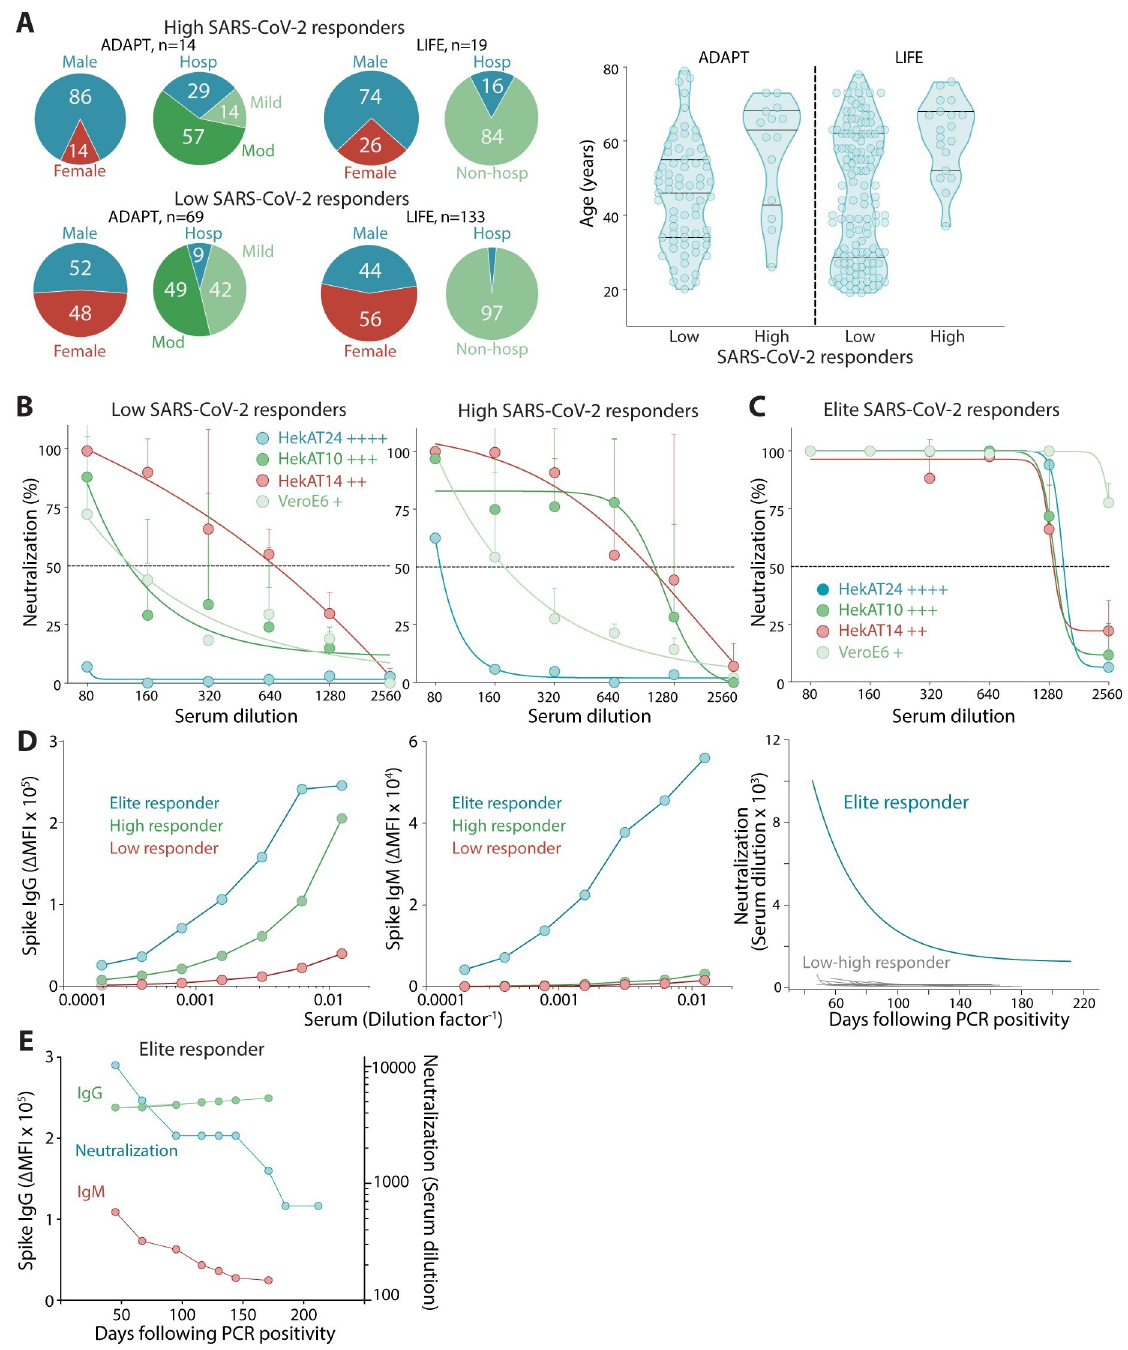
Fig 4. High and elite responders are discriminated with SARS-CoV-2–permissive cells. (A) Patients with high and robust SARS-CoV-2 responses were more likely male, hospitalized (left), and of older age (right). (B) Low and high responders to SARS-CoV-2 showed limited neutralization in hyperpermissive HekAT24 clonal cells. Permissiveness is indicated by +. (C) Only elite responders showed neutralization in HekAT24 cells. (D) Serum titration curves from an elite responder (blue) showed IgG and IgM levels greater than low (red) and high (green) responders and incredibly high neutralization titers ( � 10,000) that decreased and stabilized at high levels ( � 1280). (E) The elite donor demonstrated stable high Spike IgG, but the early decrease in viral neutralization was parallel to IgM decline before stabilization (at high titer). PCR, polymerase chain reaction; SARS-CoV-2, Severe Acute Respiratory Syndrome Coronavirus 2.